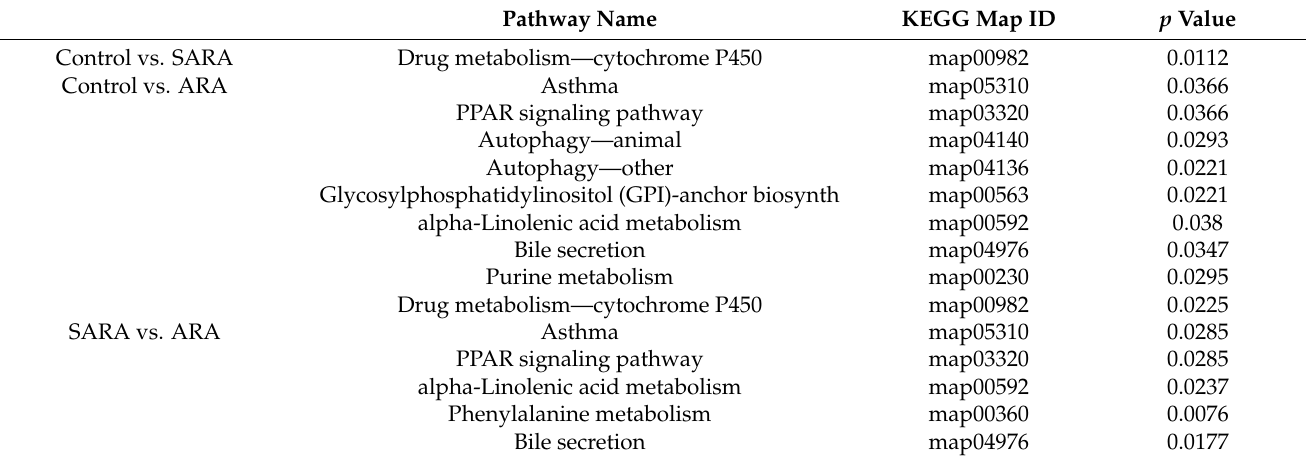
Table 3. Metabolic pathways of differential